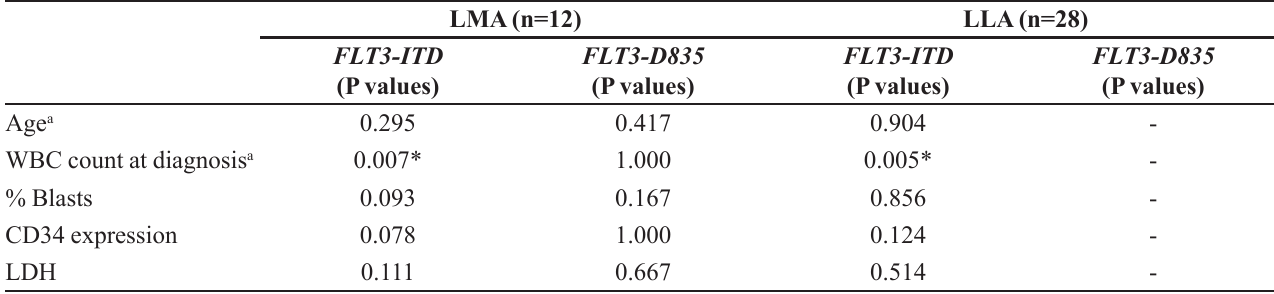
TABLE IV - Association between prognostic factors and presence of FLT3-ITD and FLT3-D835 mutations in children with acute leukemia